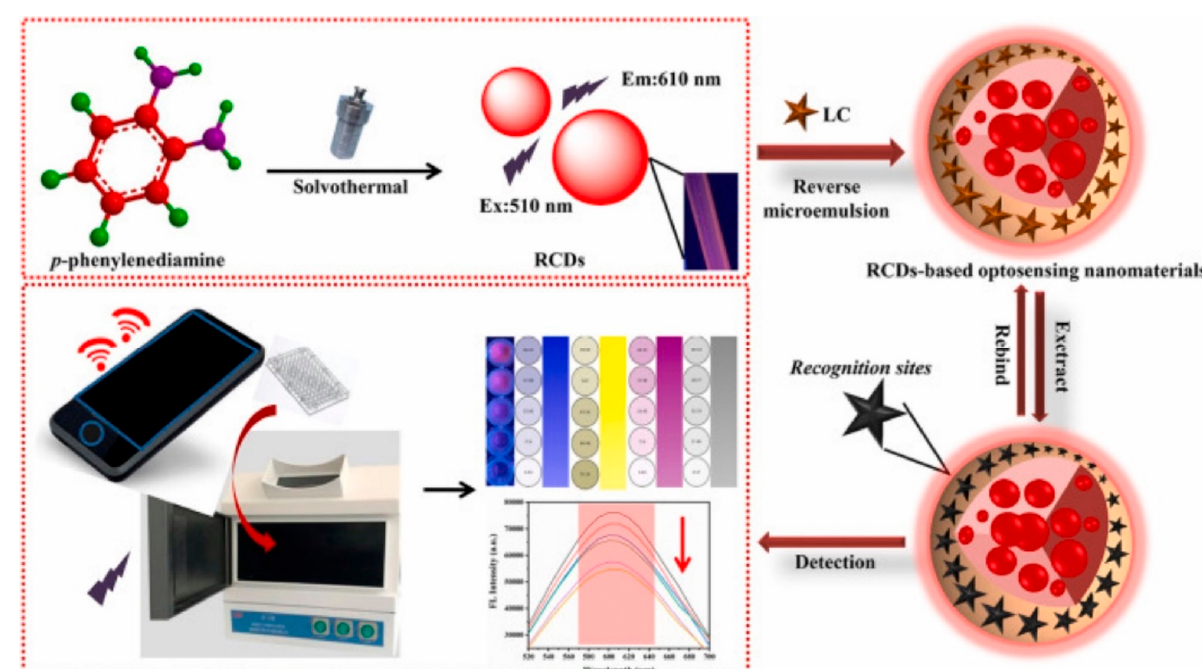
Figure 8. Schematic illustration of the platform comprising RCD-based optosensing nanomaterials for the detection of LC ([102]).